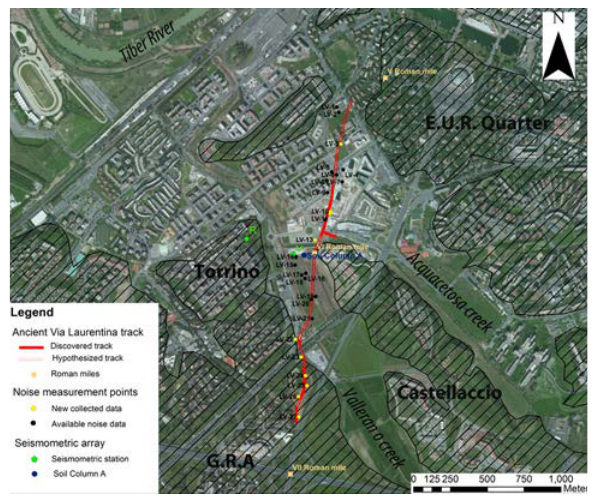
Figure 7. Location of the ancient Via Laurentina road in the southern part of Rome and sites of noise measurements along the route. The shaded areas correspond to outcrops of seismic be- drock. V and R indicate the seismic stations on alluvial deposits and seismic bedrock,